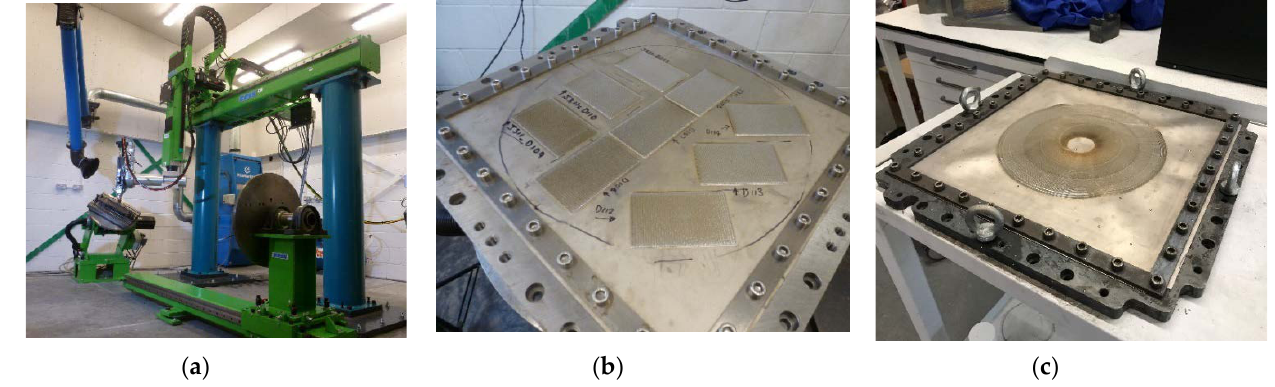
Figure 4. LMD fixture and sheet for LMD: ( a ) LMD processing cell. ( b ) Fixture with CP-Ti50A sheet mounted on T-slot table; ( c ) Completed LMD deposits on sheet.